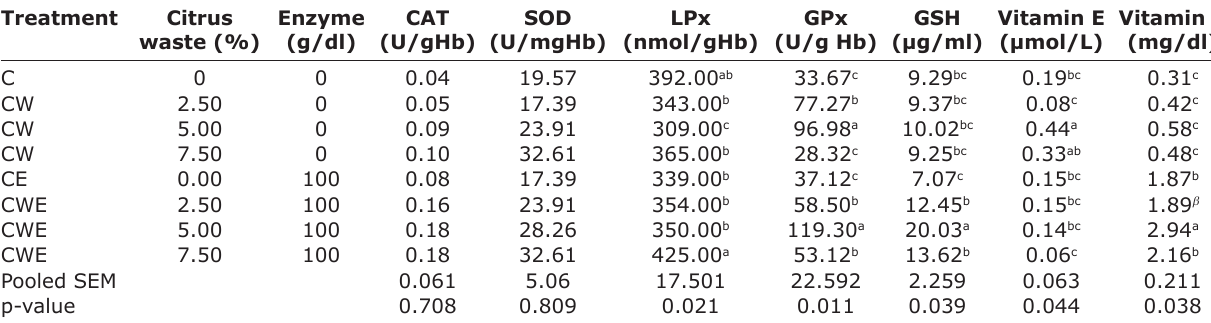
Table-12: Effect of citrus waste × enzyme on the antioxidant status of blood in broiler.